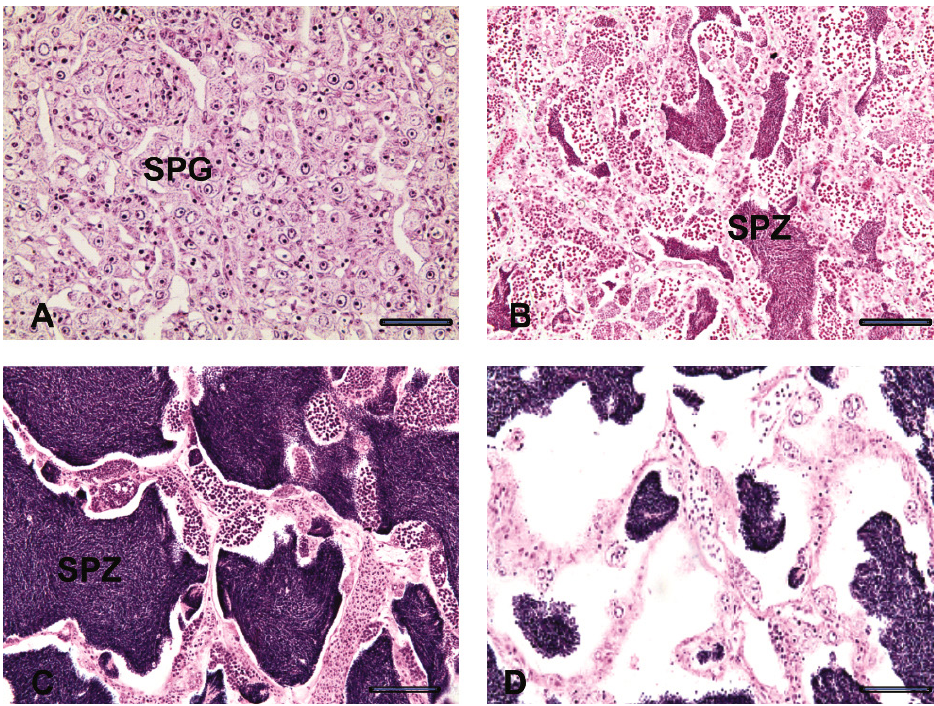
FIGURE 2 | Histological sections of testes of Leporinus piau in different stages of gonadal maturation stained by HE. ( A ) At rest (M1), containing only spermatogonia (SPG) and lumen of closed seminiferous tubules. ( B ) Initiation of maturation with a small number of spermatozoa (SPZ) in the lumen of the seminiferous tubules. ( C ) Maturation/mature (M2), with seminiferous tubules filled with spermatozoa (SPZ). ( D ) Spent (M3), with the lumen of the seminiferous tubules open and an appreciable amount of spermatozoa. Bars: A and D = 40μm; B and C =